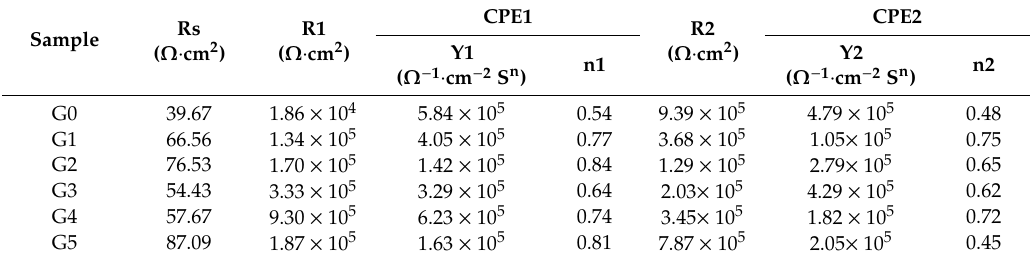
Figure 8. EIS spectra of bare D16T Al alloy and the coated samples immersion in 3.5 wt.% NaCl solution for 2 h: ( a ) Nyquist plots; ( b , c ) Bode plots. Table 3. Electrochemical parameters obtained from the EIS spectra of PEO